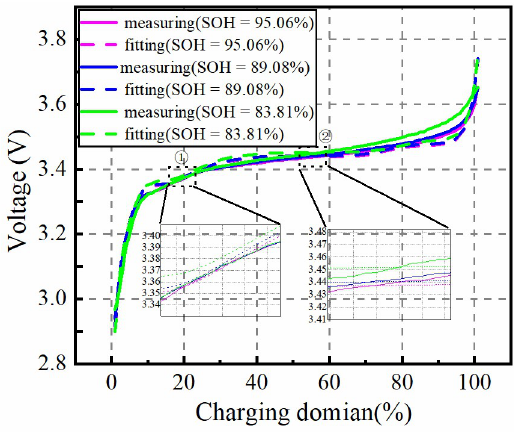
Figure 9. Validation of identification results of Q n and P D s,n .